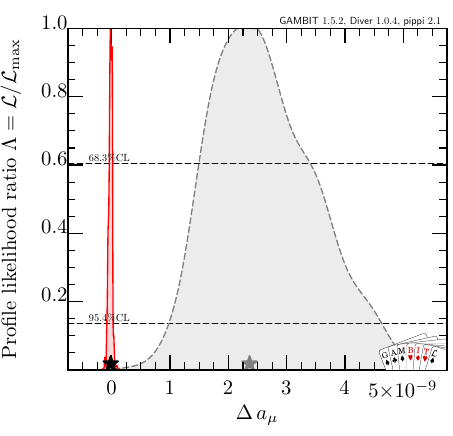
Figure 16 . One-dimensional profile likelihood for ∆ a µ . The solid red line shows the result from the fit using all likelihoods and observables defined in this study. The dashed gray line is obtained using all but the HEPLike likelihoods